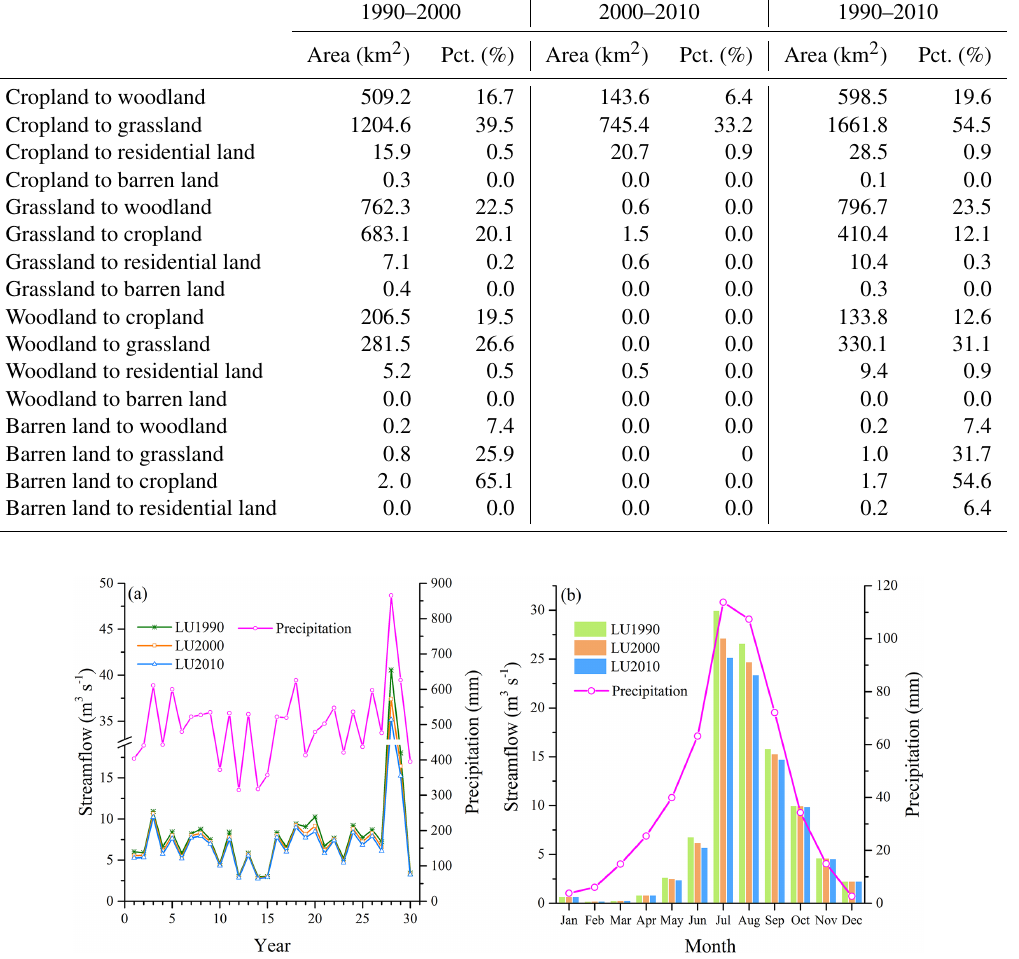
Figure 6. (a) Simulated annual streamflow and (b) simulated multi-year average monthly streamflow (the data were averaged from 1986 to 2015) at the outlet of the Yanhe Basin under different land use